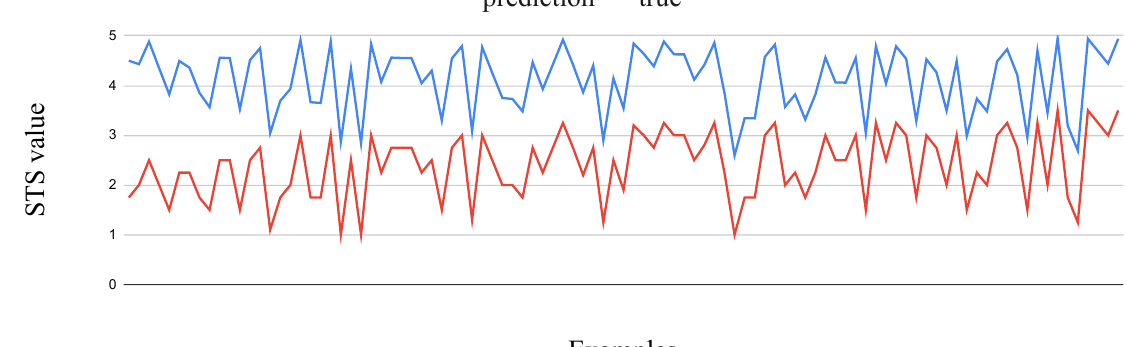
Figure 1. Top 100 examples of ASSIN2 with greater distance between predicted and true values of the STS task, where such distance is greater than